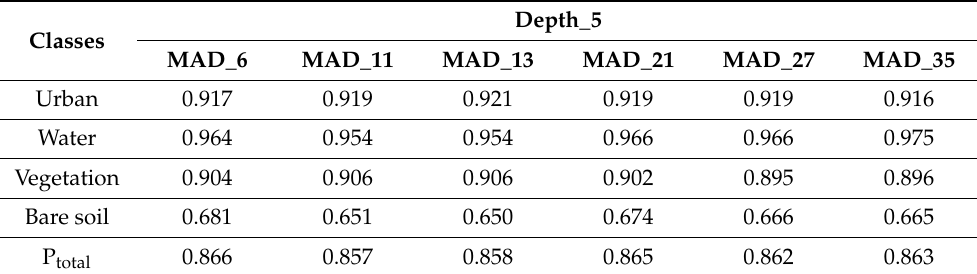
Table 10. Probabilities for classes and total probabilities of correct classification for depth 5 and different